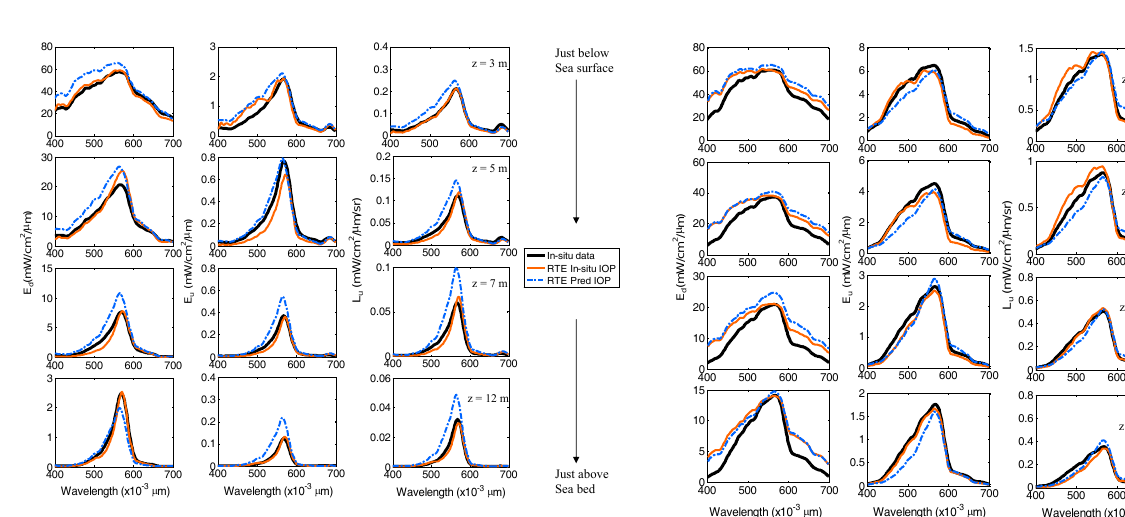
parent optical properties (AOPs), IOPs and other parameters were made when the solar zenith angle was 4.55 ◦ . At this station, the benthic resuspension and sediment transport no- ticeably increased the magnitude of the IOPs and turbidity. The measured E d spectra (first column) show the maximum values at green wavelengths (0.555 µm) and minimum values at blue and red wavelengths throughout the water column, which are the characteristic features of turbid waters. Note